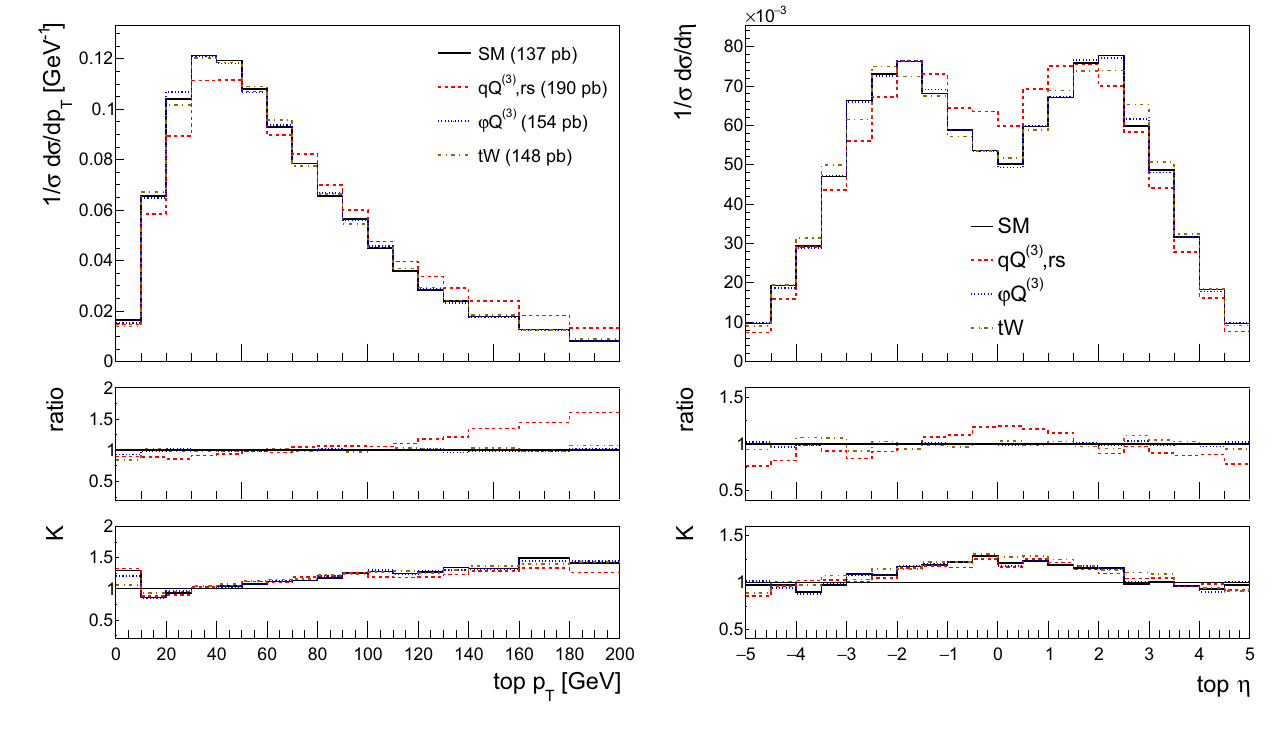
shown in the first inset is defined as the effect of the operator over the SM, the second inset shows the K -factor, the ratio of the NLO over the LO predictions